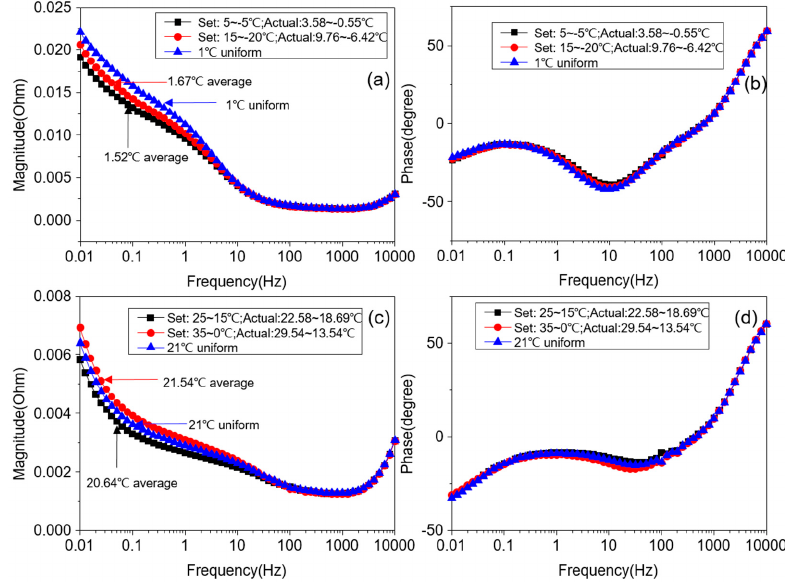
Figure 14. EIS of battery with approximate average temperature: ( a , b ) impedance magnitude and phase of battery with approximate 1 °C average temperature; ( c , d ) impedance magnitude and phase of battery with approximate 21 °C average temperature.